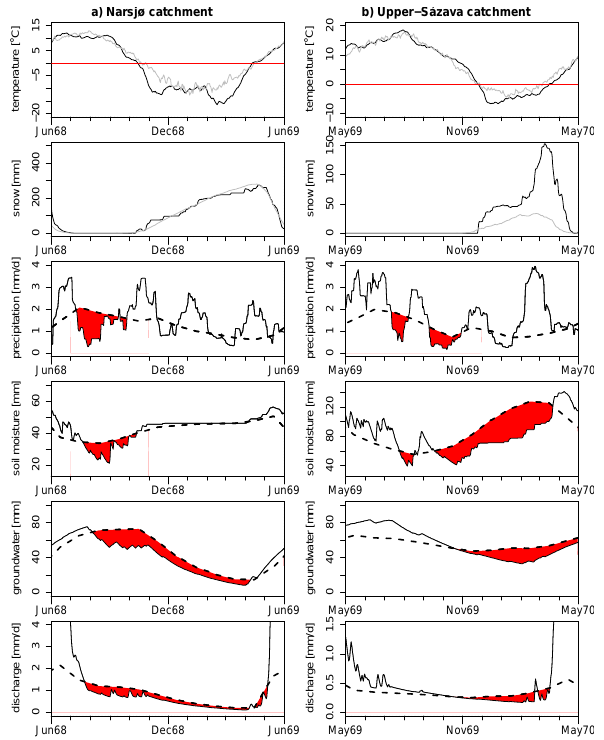
Fig. 6. Examples of rain-to-snow-season drought type: (a) Narsjø catchment 1968–1969, (b) Upper-S´azava catchment 1969–1970 (legend: see Fig. 5). The rain-to-snow-season drought occurs in catchments with a clear snow season, which can be catchments at high latitude or high elevation (K ¨ oppen-Geiger climate types D and E, and some subtypes of C). These catchments have a low-flow season in winter due to the continuous snow cover that hampers recharge. Durations of rain-to-snow-season droughts are long (almost up to a year; in the examples of Fig. 6, 279 and 147 days for drought in discharge) and deficit volumes can be high (partly due to the long durations; in